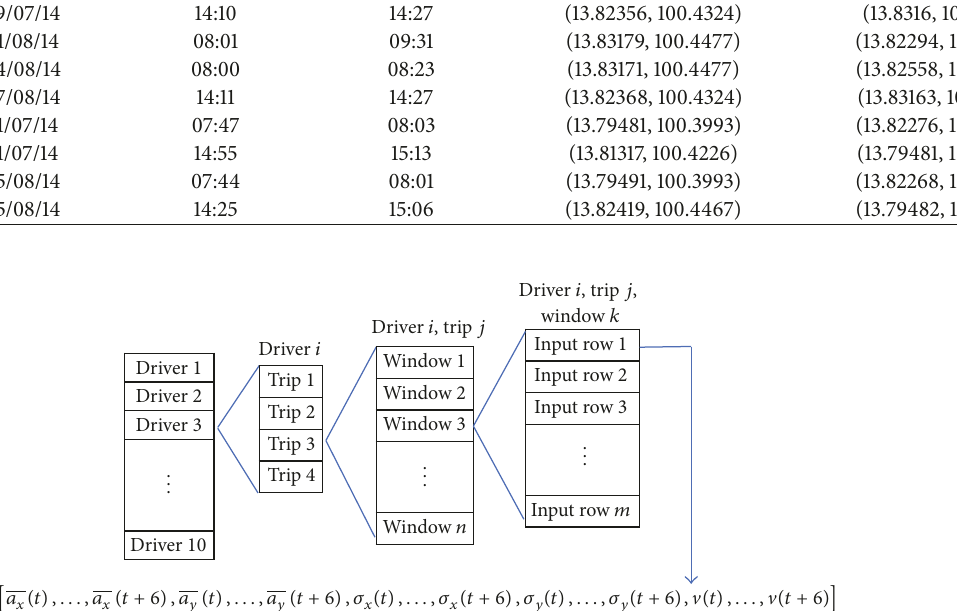
Figure 3: Input setup for the performance evaluation. Each input row is represented as a vector of time-series data, where a denotes the mean of acceleration, 𝜎 denotes the standard deviation of acceleration, and V denotes instantaneous